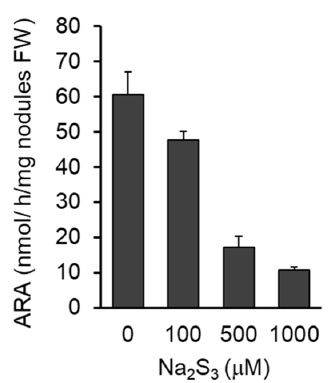
Figure 6. Effect of Na 2 S 3 on nitrogenase activity of nodules. Acetylene reduction activity (ARA) was measured at 4 weeks post inoculation. L. japonicus MG-20 was used as a host plant. Values indicate means ± SE ( n = 12). All values showed significant difference (Student’s t -test, p < 0.05).